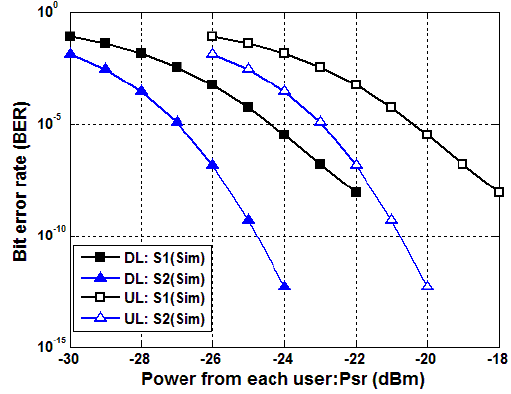
Figure 5. Bit-error rate (BER) comparison between numerical and simulation results for Classes 1 and 2.